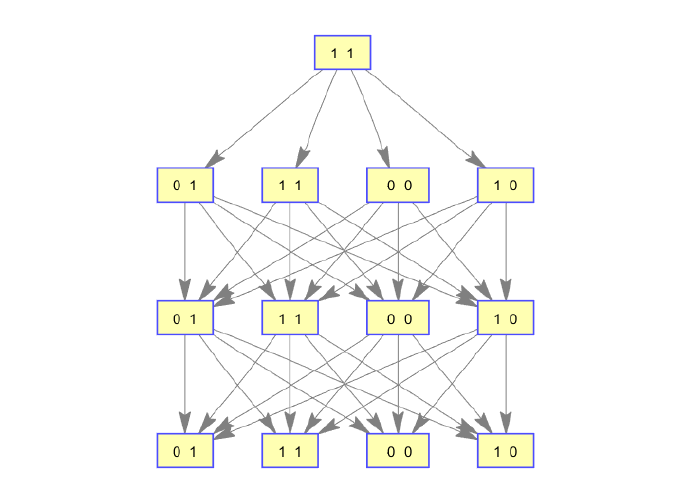
Figure 4. Markov Process over time. In this case 2 components which can be either working (1) or faulty (0) are considered for 3 time steps. The total number of states for each time step is